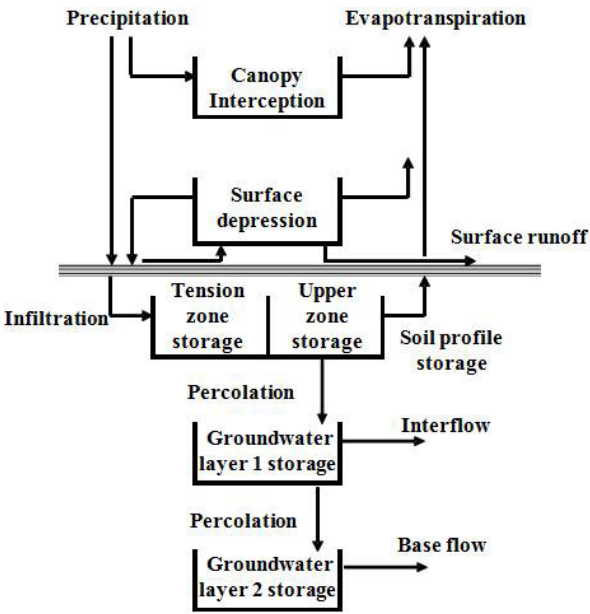
Fig. 1. Structure of the HEC-HMS Model (Bennett and Peters,